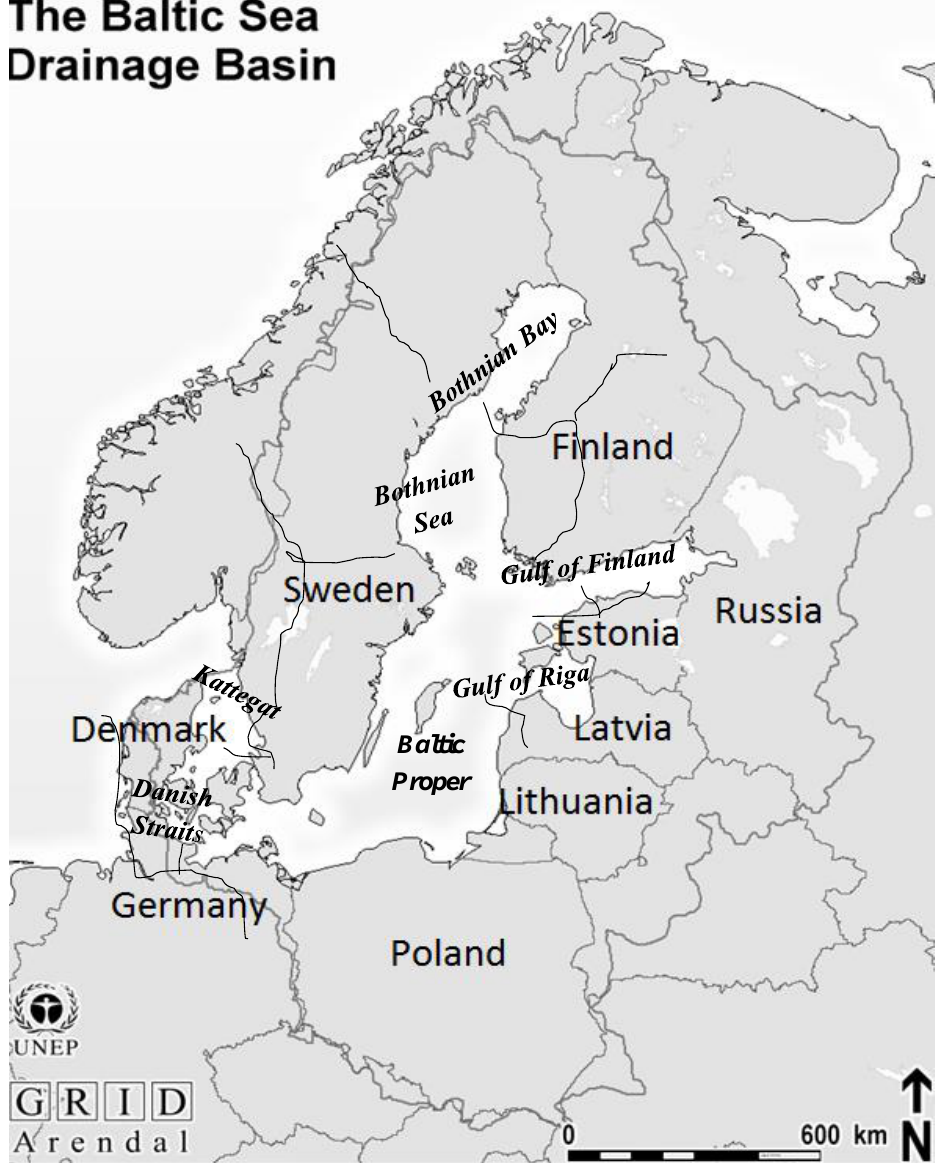
Figure A1. The Baltic Sea drainage basin. Source: Gren and Tirkaso [21].